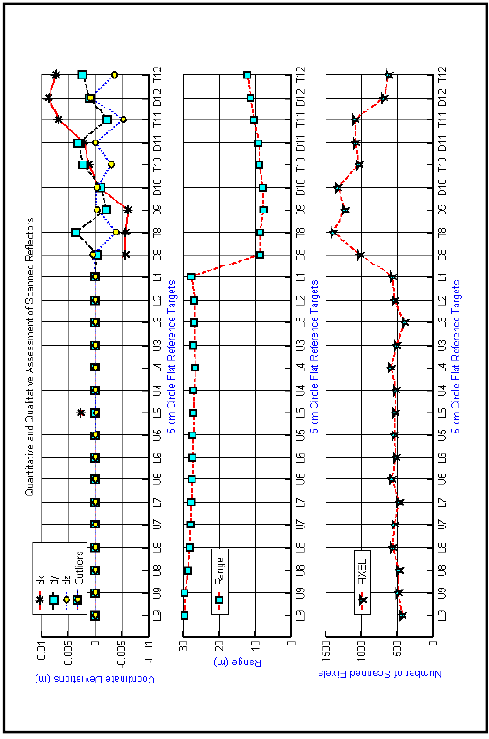
Figure 5: Accuracy and its relation with the number of pixels at Station 1